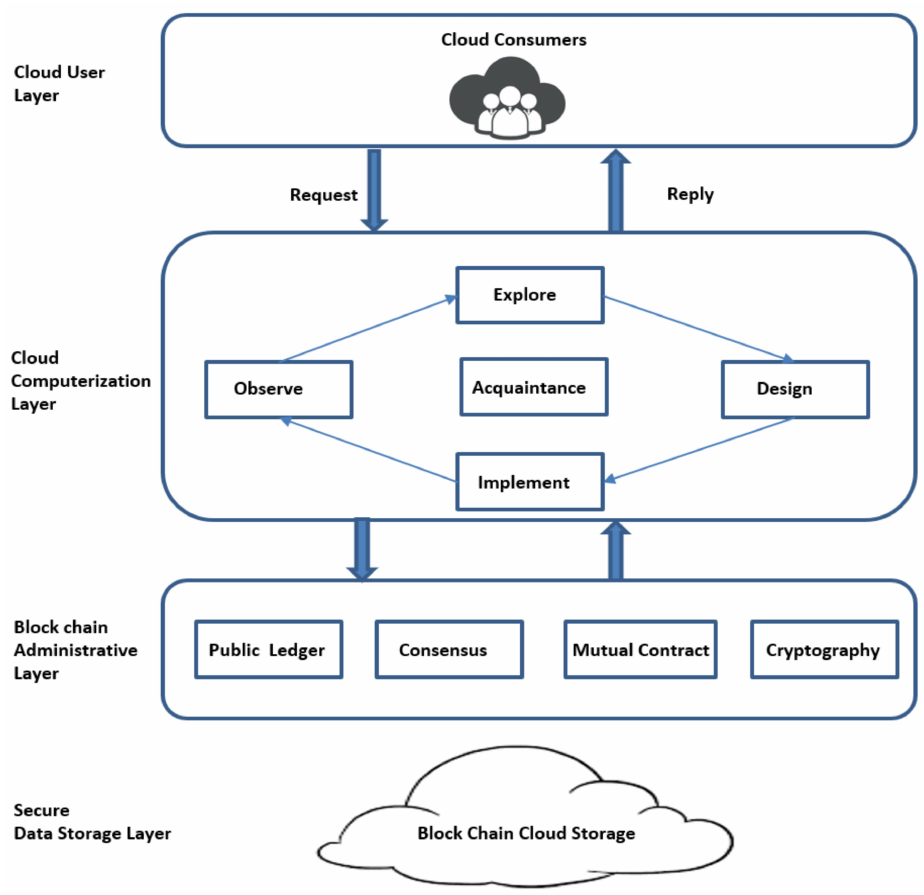
Figure 4. Secure Block chain QCPABE based Cloud